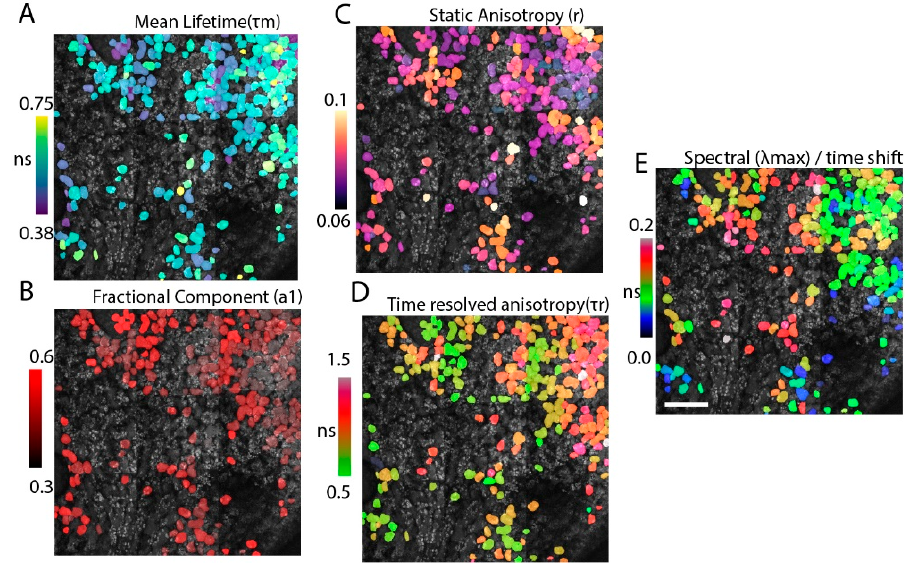
Figure 4. Multiparametric Collection. The contrast from different fluorescence modalities is compared here. The images are segmented for cotyledon epidermal cells, and each parameter per-cell is colored and overlaid on the intensity image (in grayscale). ( A ) the lifetime curves are fit using a 5 × 5 kernel size and fit to multiexponential fits. The mean lifetime is colored in this scheme. ( B ) The fractional component of the smallest lifetime species (anthocyanins) is shown. ( C ) The static anisotropy parameter (r) derived as a ratio of depolarized light to total emission light is shown here. ( D ) The time-resolved anisotropy curve (r(t)) is fit to multiexponential fit and plotted for the mean rotational time. Note that these values are higher than anthocyanin lifetime, and only the smallest (green) values represent anthocyanins. ( E ) The peak-wavelength parameter is derived from the fiber-shift calculation and overlaid as previous panels. Panels C and B are ratio-metric quantities without units. All five panels show different parameters, showing different contrast between cells.